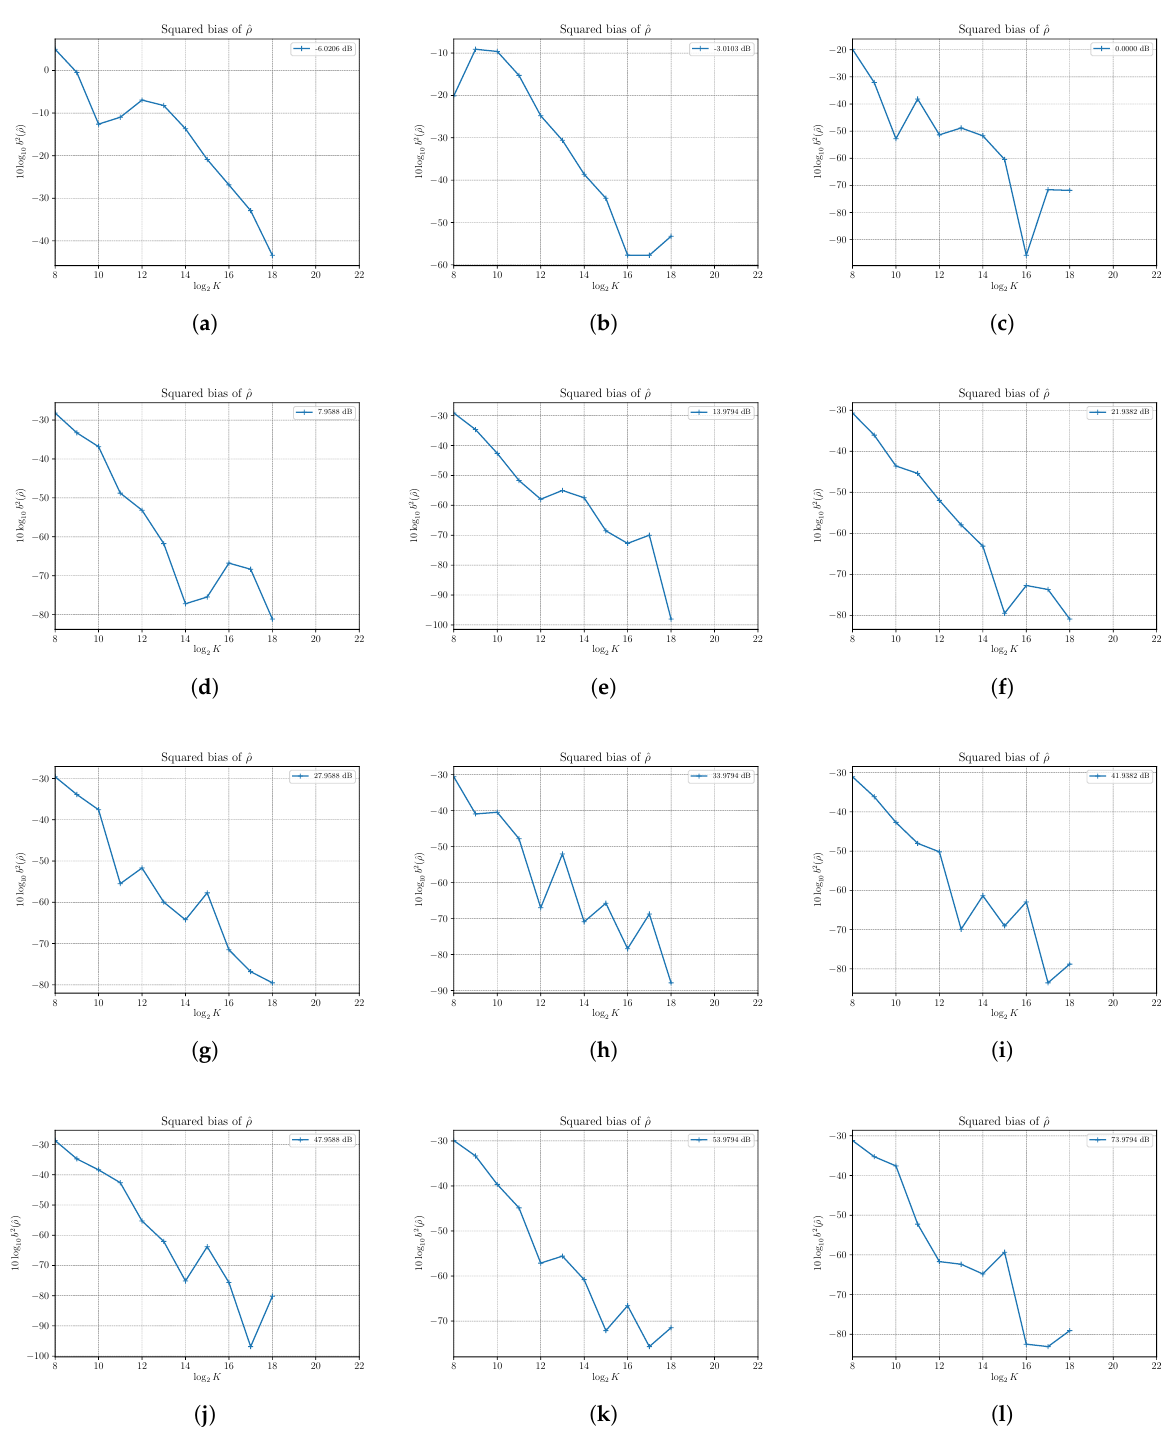
Figure 7. The estimated squared bias b 2 ( ˆ ρ ) of the SNR estimator ˆ ρ versus the number of observations K . Each sub figure ( a – l ) shows results for a given nominal value of SNR obtained by changing the signal power S and with noise power N =